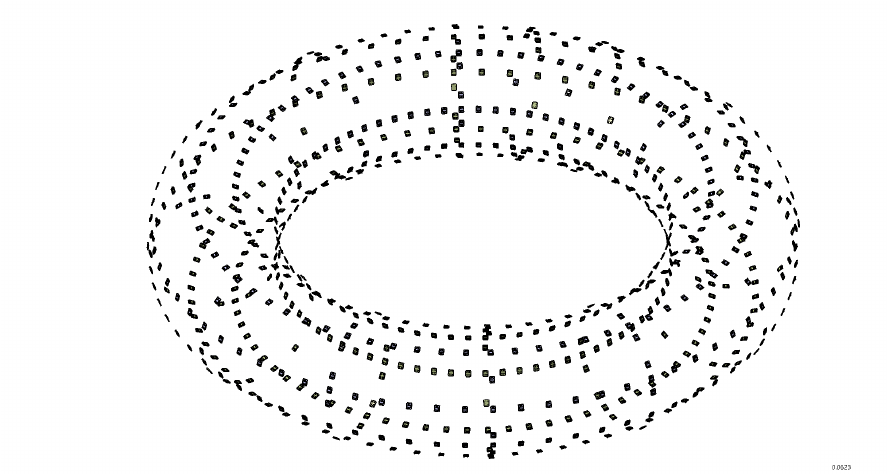
Figure 11. Layout of the 8 toroidal and 13 poloidal arrays of pick-up coil